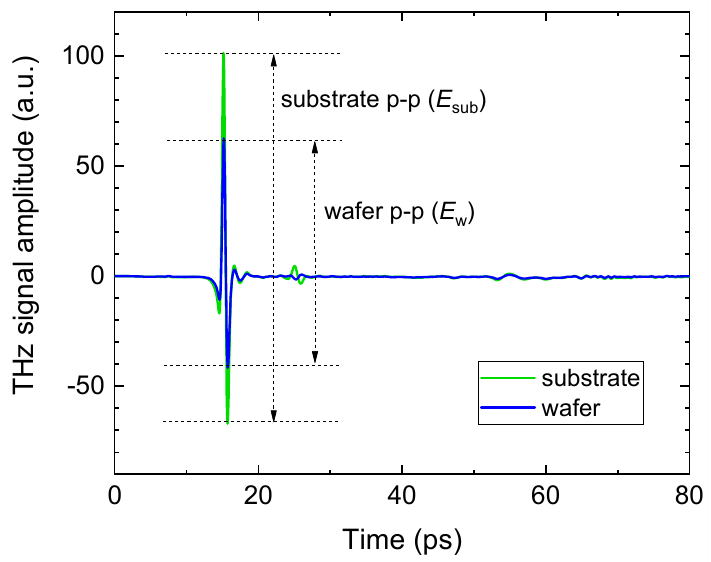
Figure 3. Time-domain traces through a bare substrate glass wafer and through a coated wafer, showing reduced transmission through the coated wafer and indicating the peak-to-peak values used in calculating frequency-averaged sheet resistance.